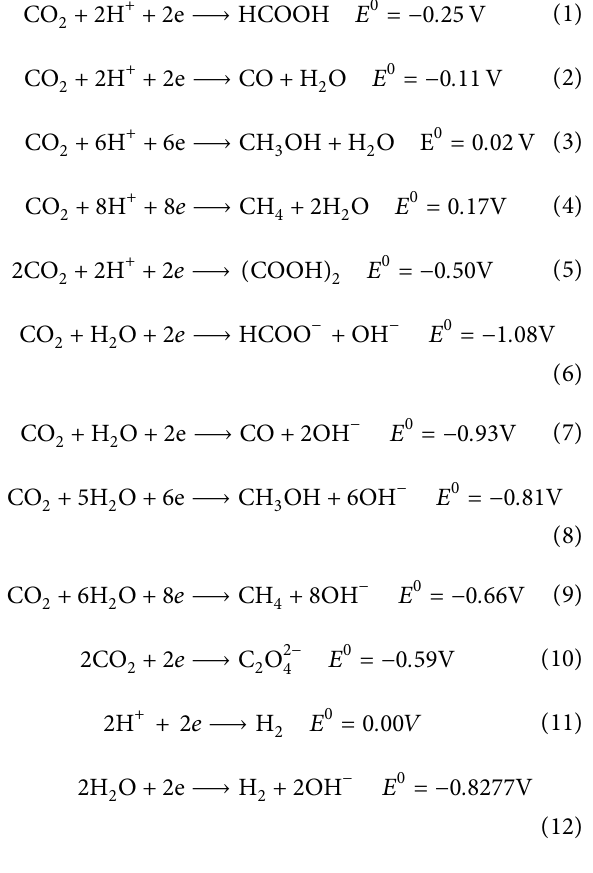
Figure 2: Carbon dioxide reduction cycle using renewable and green sources of energy from [15] under the terms of the Creative Commons CC BY